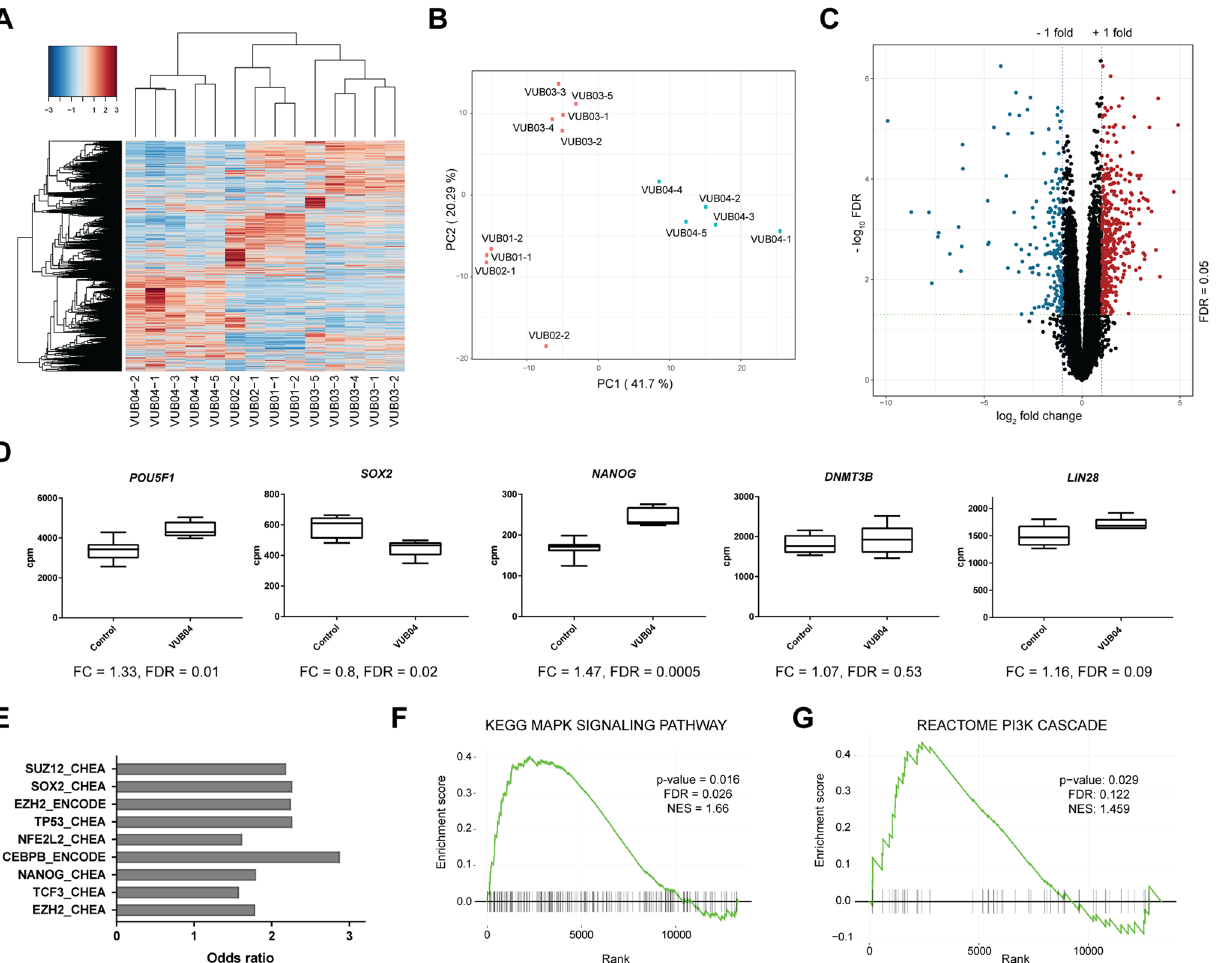
Figure 3. Transcriptomic analysis reveals that VUB04 has a distinct expression profile at the undifferentiated stage. ( A ) Unsupervised hierarchical clustering and heatmap of transcriptome data of all lines tested. ( B ) Principal Component Analysis of dimension 1 versus dimension 2 based on normalized transcriptome data. ( C ) Volcano plot based on a comparison of gene expression levels between VUB04 and the control group (VUB01, VUB02 and VUB03). Genes with |log 2 fold change|> 1 and FDR < 0.05 were marked as either significantly upregulated (red) or downregulated (blue). D) Normalized expression values for selected pluripotency markers in the control group and VUB04. FC fold change. ( E ) Transcription factor enrichment for the top deregulated genes in VUB04 (based on top |log 2 fold change| and FDR < 0.05) done by the Enrichr tool and based on CHEA and ENCODE databases.) ( F ) and ( G ) Enrichment profile for MAPK/ERK signalling ( F ) and PI3K signalling ( G ) performed on the ranked gene list based on a comparison of the expression levels between VUB04 and the control group. Rank 0 represents the gene with the highest-ranking score. Vertical black bars represent genes within the ranked list belonging to the given pathway. NES normalized enrichment